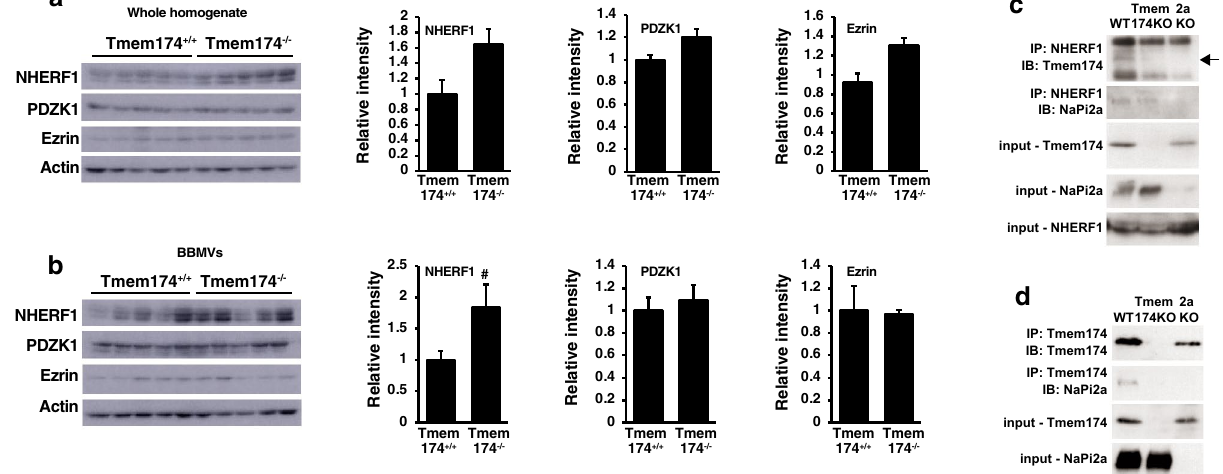
Figure 7. Scaffold protein levels in Tmem174 −/− mice. Western blot analysis of scaffold proteins in Tmem174 +/+ and Tmem174 −/− mice fed normal mouse chow. Each lane was loaded with 20 μg of renal whole homogenate ( a ) and BBMVs ( b ). Actin was used as an internal control. Values are mean ± SE. # p < 0.05. Immunoprecipitation of NHERF1 ( c ) or Tmem174 ( d ) from renal BBMV lysates of WT, Tmem174-KO and NaPi2a-KO mice fed the normal mouse chow and immunoblotting with anti-Tmem174, -NaPi2a or -NHERF1 antibodies. Arrow indicates the Tmem174. Experiments were repeated at least 3